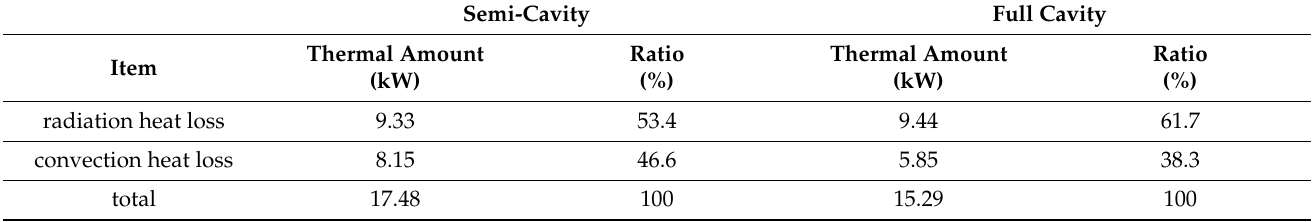
Table 4. Heat loss according to cavity shape.